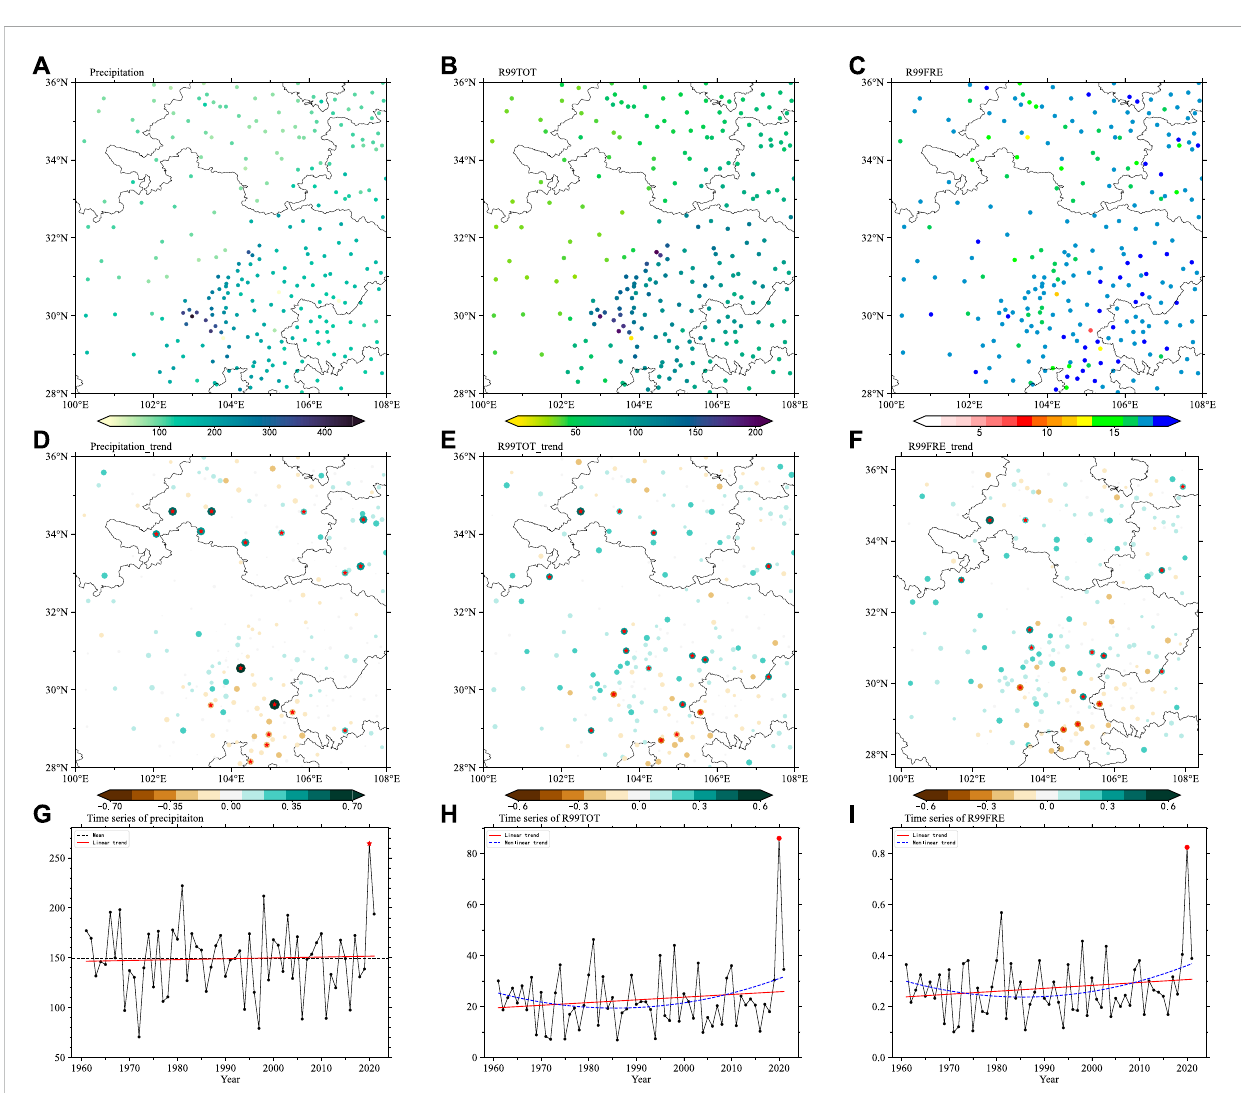
FIGURE 2 Spatial distributions of (A) precipitation, (B) R99TOT, (Unit: mm), and (C) R95FRE (Unit: times), with units of mm and times, as well as the linear trend of (D) precipitation, (E) R99TOT (Unit: mm/year), and (F) R95FRE (Unit: times/year) in WC during late summer from 1961 to 2021. The dotted stations indicate signi fi cant values at the 95% con fi dence level based on the Student ’ s t -test. The time series of regional (G) precipitation, (H) R99TOT, and (I) R95FRE in WC are plotted in black lines. The solid gray line in (G) represents the average precipitation. The red and blue dotted lines in (H) and (I) represent linear and non-linear trends,